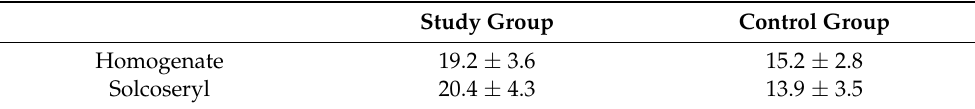
Table 3. Mean corneal anterior epithelial thickness ( µ m) measured by histo-pathology 9 weeks after corneal